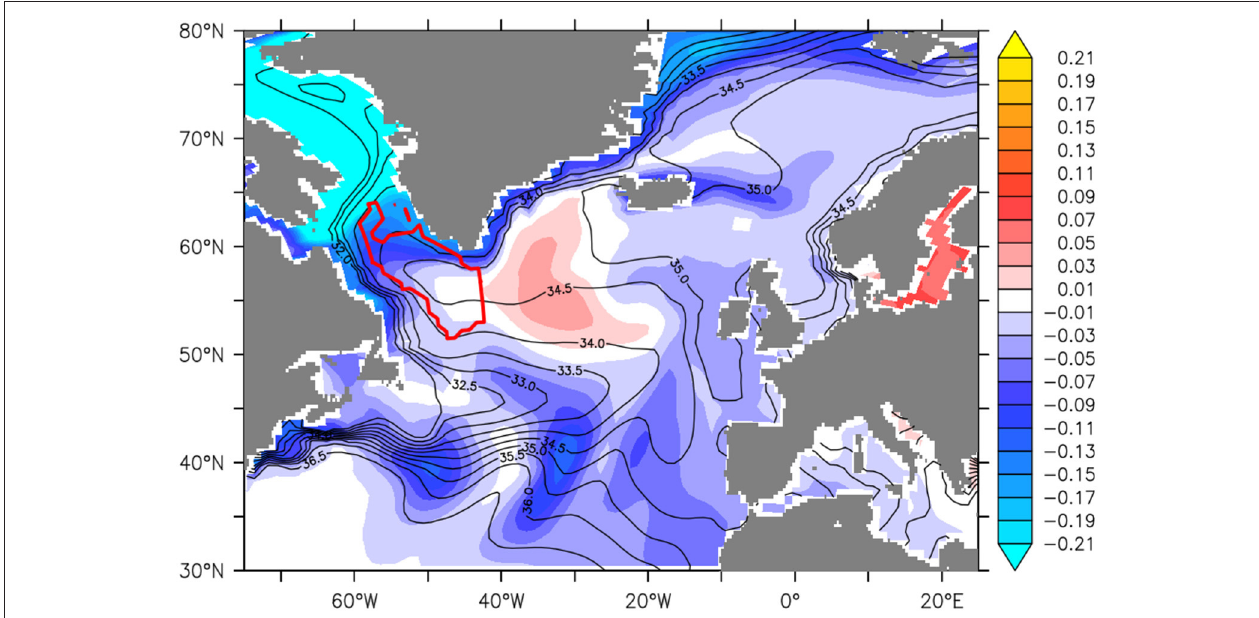
FIGURE 3 | SSS anomalies (averaged over the 20 members and over the 95 years of simulation in January–February–March) in LR simulations expressed in PSU. The mean state of the control simulations averaged over the same period is shown in contour. The red contour is representing the convection site definition of the Labrador Sea in the LR historical simulations (defined as the region where the MLD is larger than 600m at least during 1 month in the control